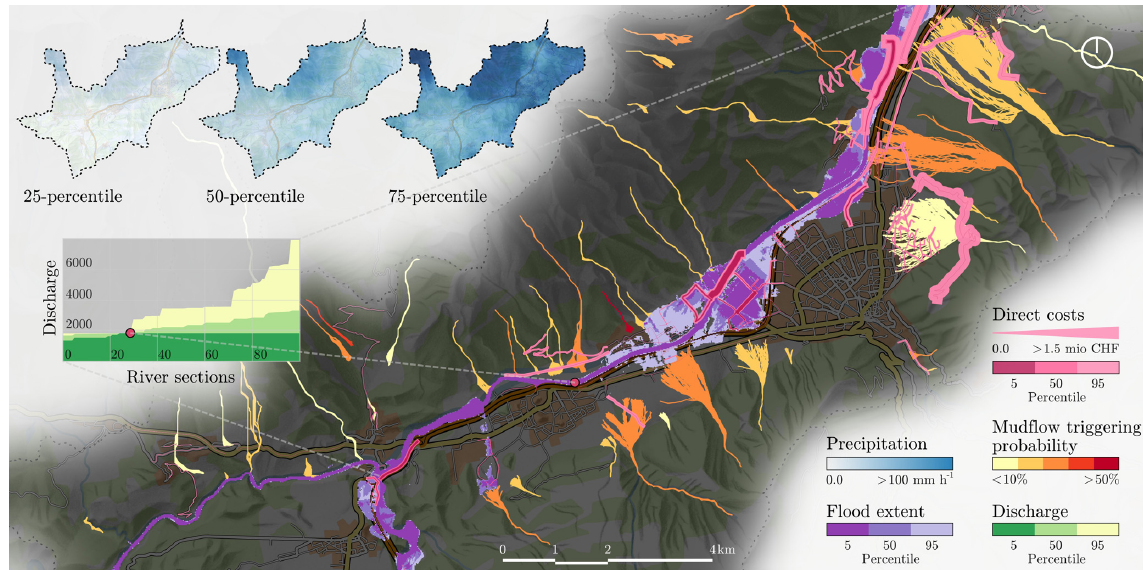
Figure 8. Aggregation of multiple simulations for hazard events with 500 year return period. This map visualizes the uncertainties related to these events. For example, only 5% of the floods exceeded the light purple floodplain (95% percentile), while only 5% of the floods resulted in floodplains smaller than the dark purple area (5% percentile).